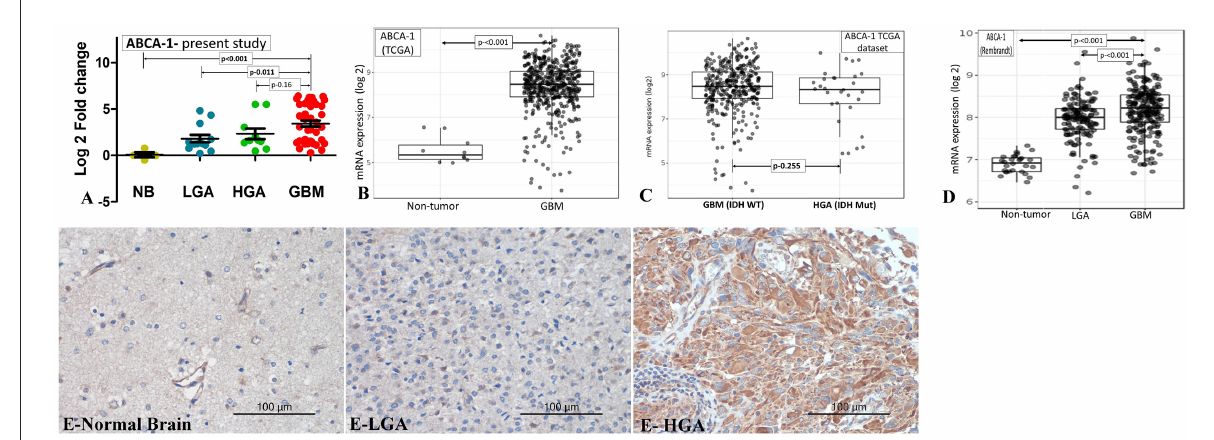
FIGURE2 ABCA-1 expression. (A–D) mRNA expression. The mRNA expression of ABCA-1 in cases of GBM and its comparison with IDH mutant lower grade astrocytic tumors (LGA)/ higher grade astrocytic tumors (HGA) in the present study (A) , TCGA dataset [normal brain vs. GBM] (B) , TCGA dataset [GBM, IDH wild type vs. Astrocytoma, IDH mutant, grade 4] (C) and Rembrandt dataset (D) . [Mann-Whitney U test was used to ascertain the p-value depicted in the photographs. The parameters compared are denoted by ( ⇄ ) sign]. ABCA-1 immunohistochemistry in normal and